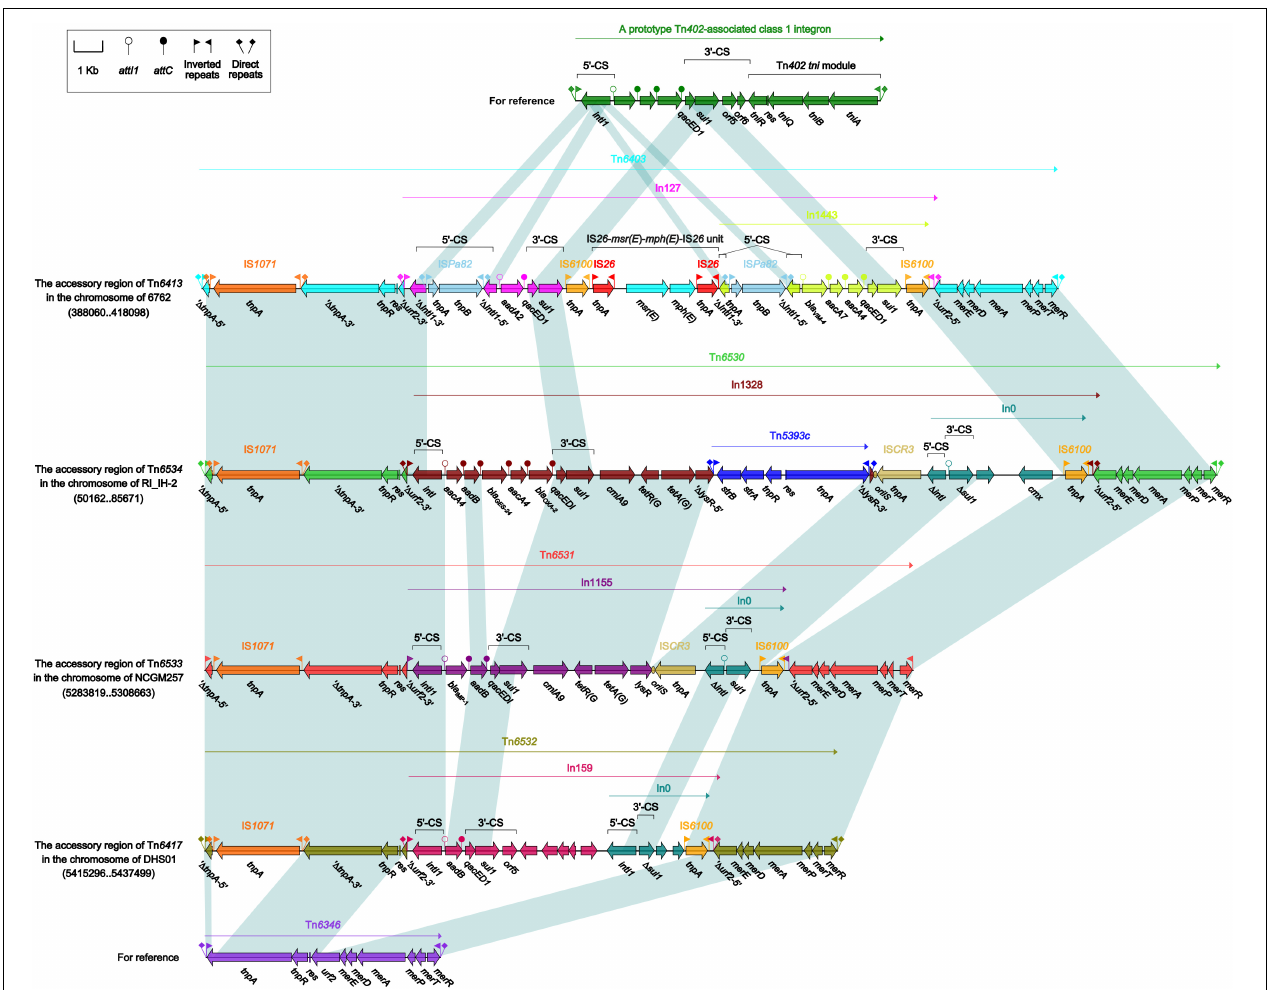
FIGURE 6 | Organization of Tn 6403 and comparison with related regions. Genes are denoted by arrows. Genes, mobile elements and other features are colored based on their functional classification. Shading denotes regions of homology (nucleotide identity > 95%). Numbers in brackets indicate nucleotide positions within corresponding chromosome sequences. Accession number of Tn 6346 for reference is